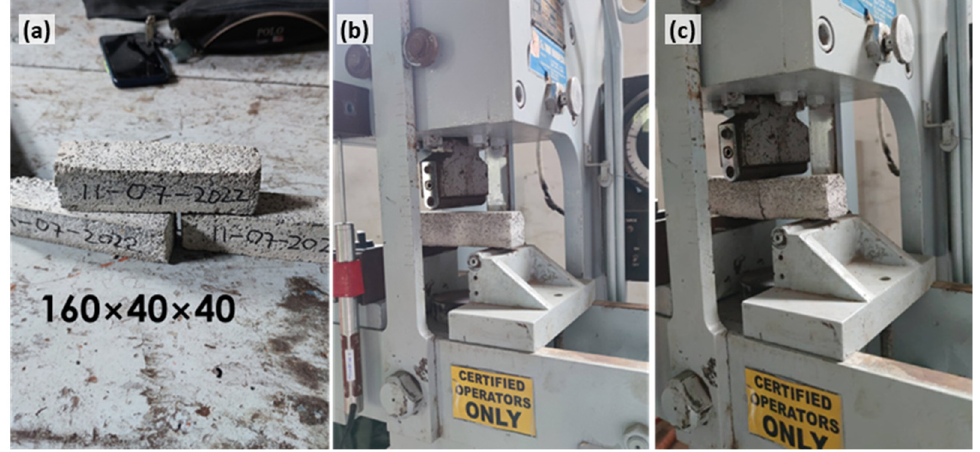
Figure 7. ( a ) Mortar specimens, ( b ) the flexural test on the mortar specimen, and ( c ) the flexural failure of the